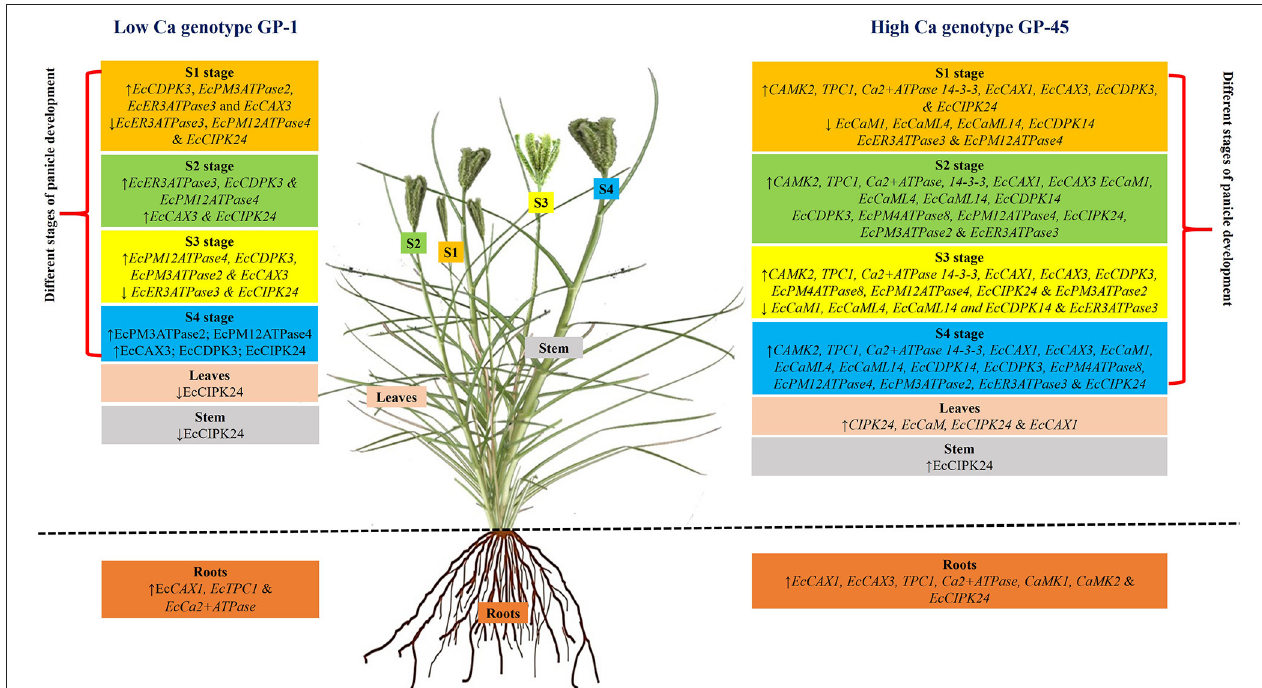
FIGURE 2 | Comparisons between genes related to calcium (Ca) uptake, transport, and accumulation identified in low Ca containing (GP-1) and high Ca (GP-45) containing genotypes. The Ca uptake, transport and accumulation related genes were identified in root, leaves, stems at vegetative stage and developing spikes at various stages of [S1 (booting), S2 (anthesis), S3 (grain ripening), and S4 (maturation)] of finger millet. Stages S1–S4 are marked with a rectangular shape and filled in orange, green, yellow, and blue, respectively. More number of Ca uptake, transport and accumulation genes were expressed in high Ca containing genotype as compared to the low Ca containing genotype.